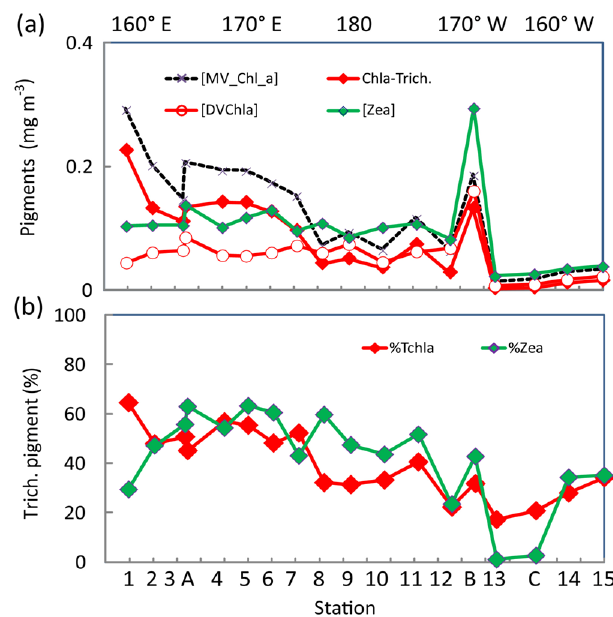
Figure 5. (a) Surface concentrations (mgm − 3 ) along the OUT- PACE transect of DV-Chl a , total zeaxanthin, total MV-Chl a and MV-Chl a related to Trichodesmium (Chl a Trich.) as obtained by appliance of pigment algorithms (see material and methods), (b) Contribution of Trichodesmium to TChl a and zeaxanthin (%). Pigments were analyzed by HPLC at NASA. The x axis represents station number (below) and main longitudes